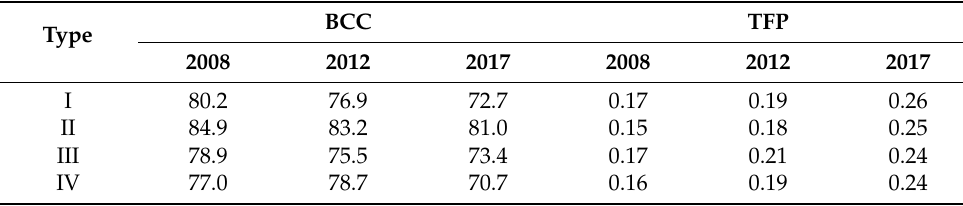
Table 8. Efficiency and total productivity of dairy farms by farm types in 2008, 2012, 2017. BCC Type